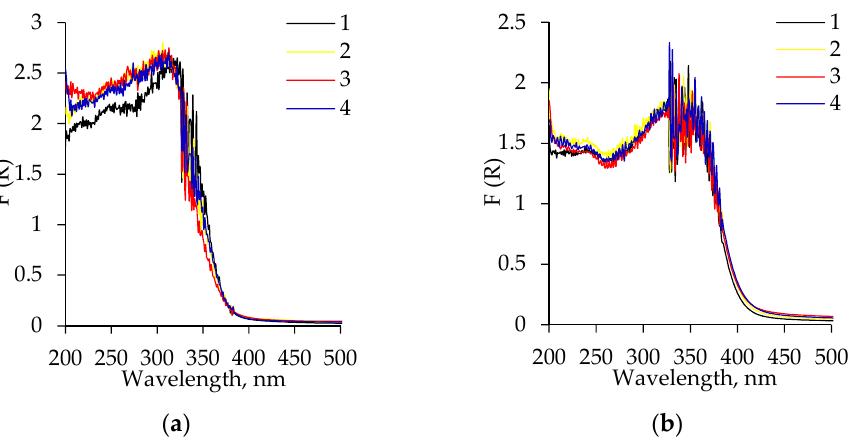
Figure 10. Diffuse reflectance spectra of the aged TiO 2 aerogels: ( a ) without calcination; ( b ) after